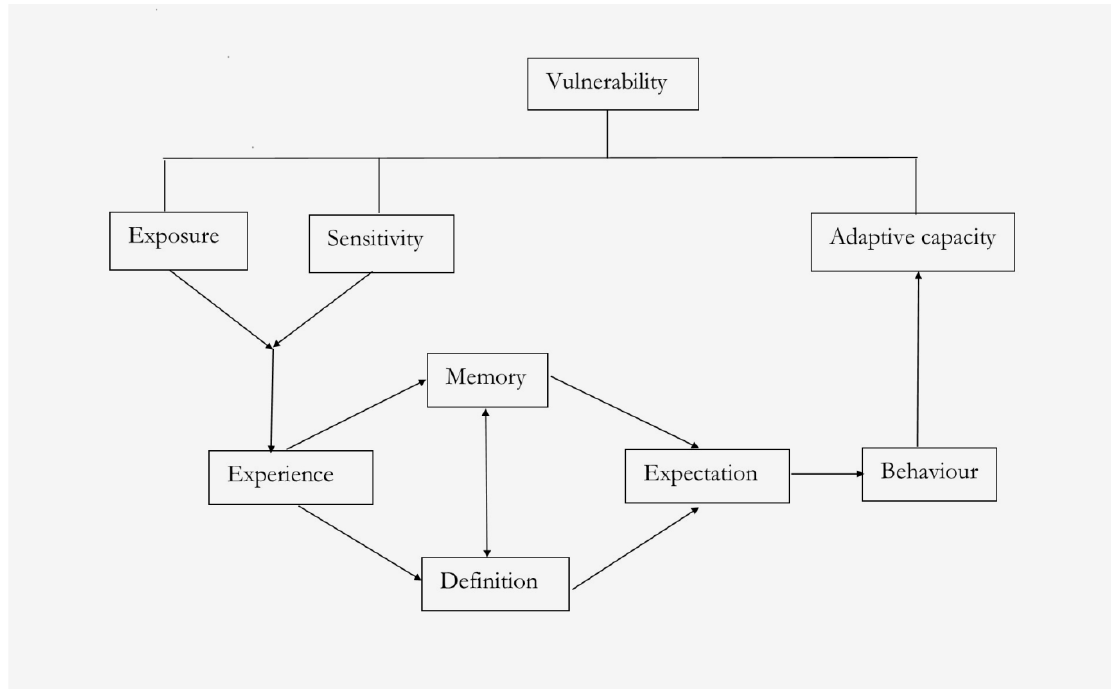
Figure 1. Vulnerability — perception conceptual framework (adapted from [38,39]).